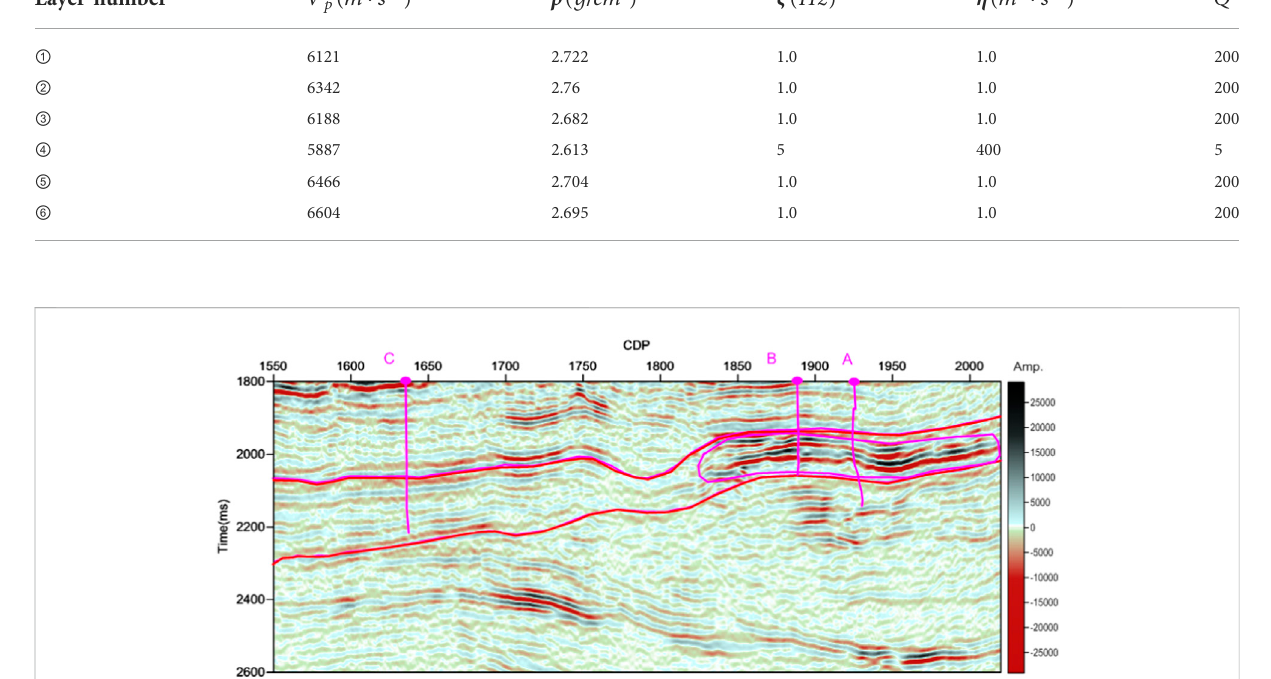
TABLE 1 Rock properties for the geological model. It is of note that ζ is the diffusion coef fi cient and η is the viscous coef fi cient. Layer number